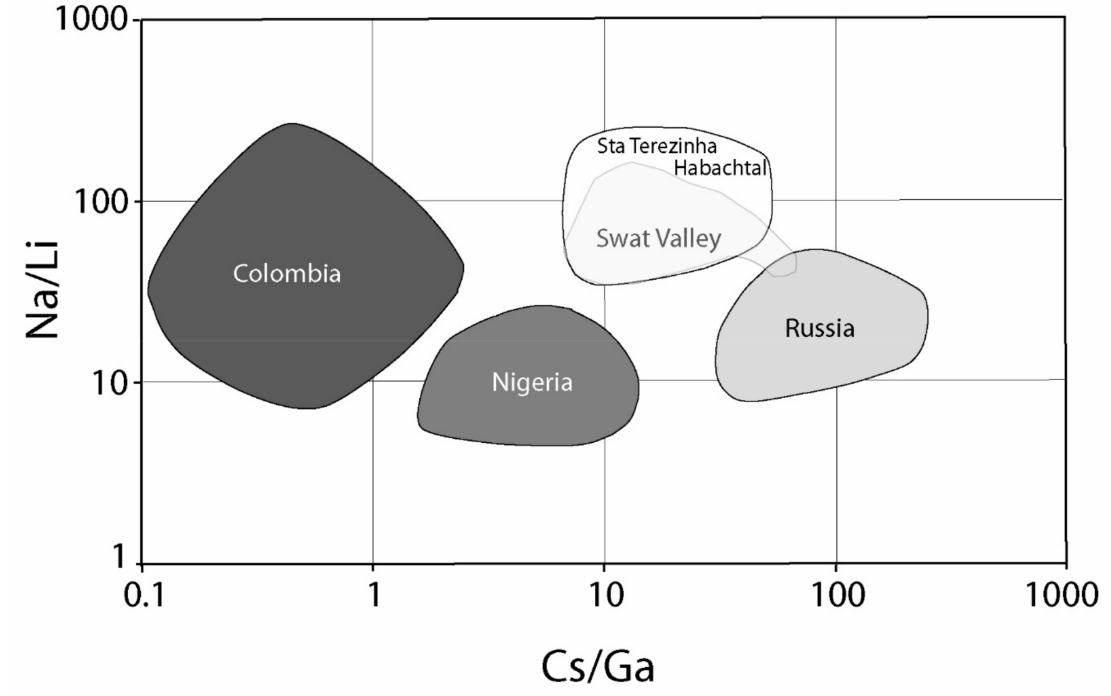
Figure 39. Cs/Ga versus Na/Li diagram of emeralds from Colombia, Nigeria, Russia, Pakistan, Austria, and Swat valley presented by Schwarz [65]. The diagram indicates that the chemical ratios of emerald from Santa Terezinha de Goi á s (Brazil), Habachtal (Austria), and Swat valley (Pakistan) plot in the same population field. They are characterized by moderate to high Cs/Ga and very high Na/Li ratios. Discrepancies are observed for the concentrations of Cs and other elements when compared with the analysis presented by Aurisicchio et al.